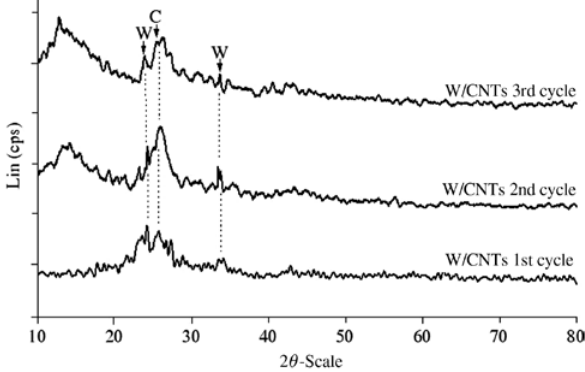
Figure 14: XRD patterns of reused W/CNT.